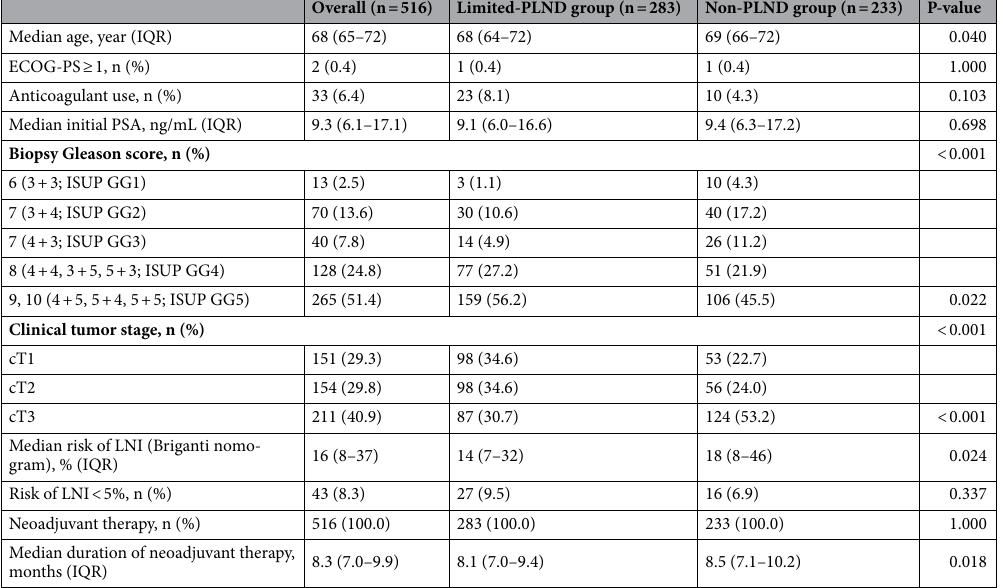
Table 1. Baseline characteristics. PLND pelvic lymph node dissection, IQR interquartile range, ECOG-PS Eastern Cooperative Oncology Group Performance Status, PSA prostate-specific antigen, ISUP GG the International Society of Urological Pathology grade group, LNI lymph node